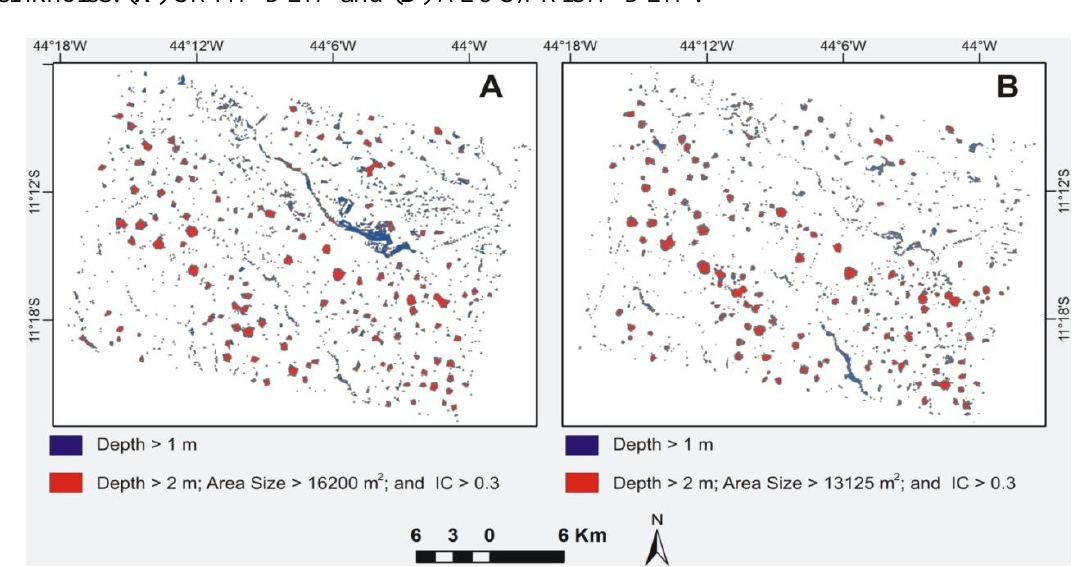
Figure 10. Comparison between delimited dolines from depth > 1 (blue polygon) and using the morphometric analysis (red polygon) that provides a significant decrease of sinkholes. ( A ) SRTM-DEM and ( B )